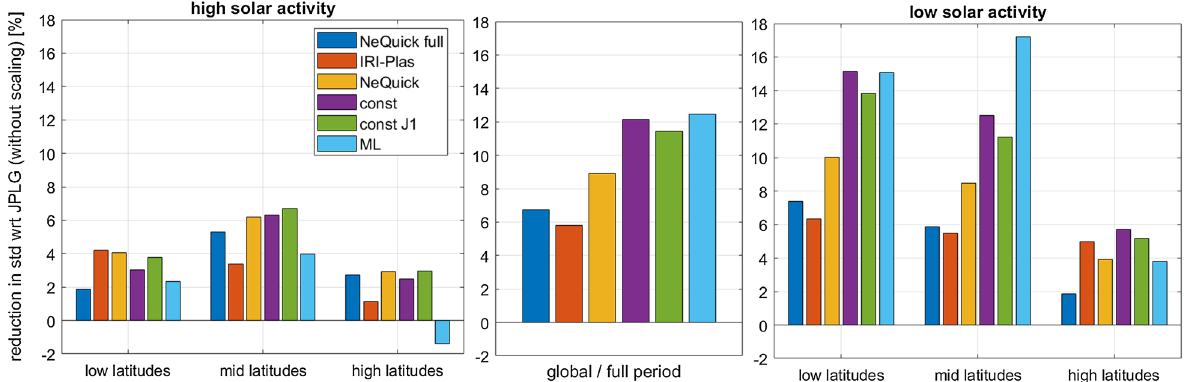
Fig. 4 Mean standard deviations for different scaling solutions, in different regions and for different solar activities. Shown is the improvement with respect to unscaled GIM in